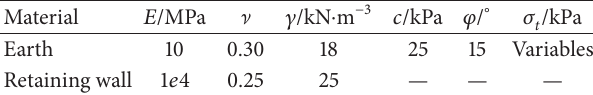
Table 5: Physical-mechanical parameters of